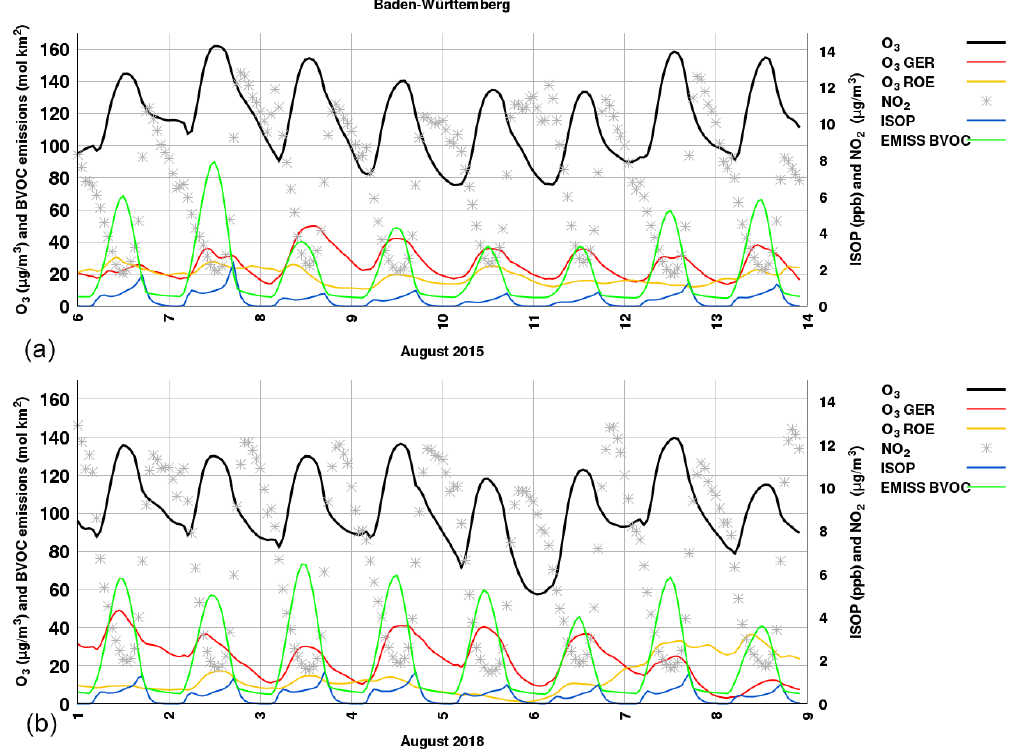
Figure 10. Diurnal variation in total ozone and its German and European components together with the total BVOC emissions and isoprene concentration for 6–13 August 2015 (a) and 1–8 August 2018 (b)